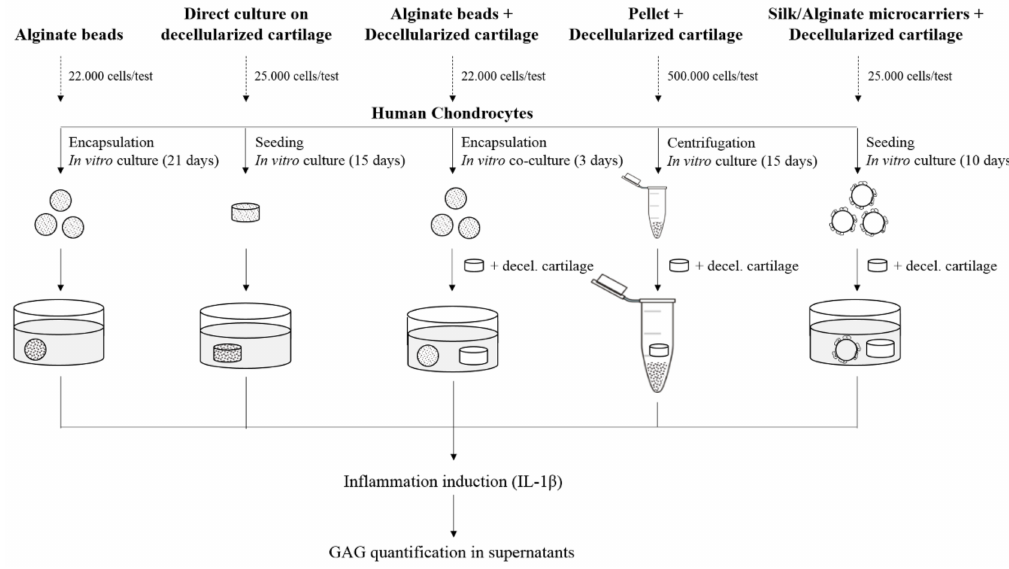
Figure 1. Schematic representation of study’s experimental design. Five 3D models were proposed considering the type of scaffolds, the number of cells/test, and the in vitro culture time as process